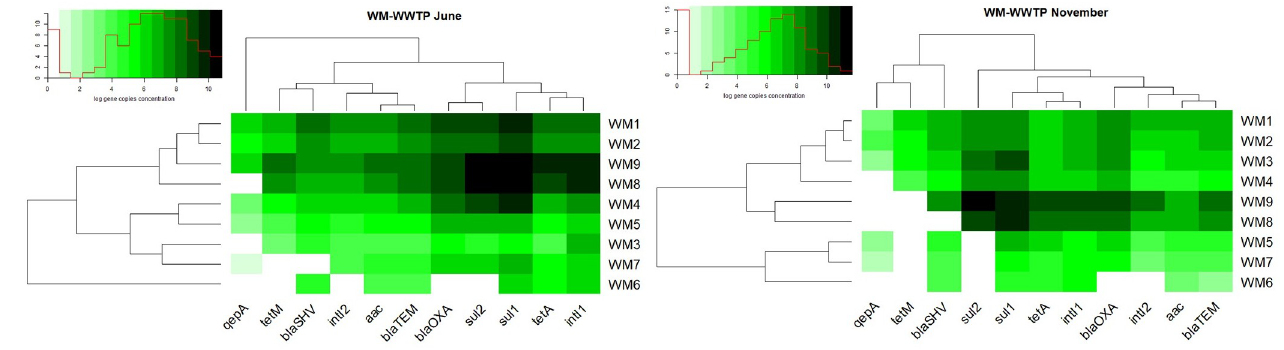
Fig 3. Distribution of log gene copies in WM-WWTP. Black spectrum colours indicate the highest average concentration, while white spectrum colours indicate the lowest concentration of genes copies. Dendrograms point out similarity clusters.